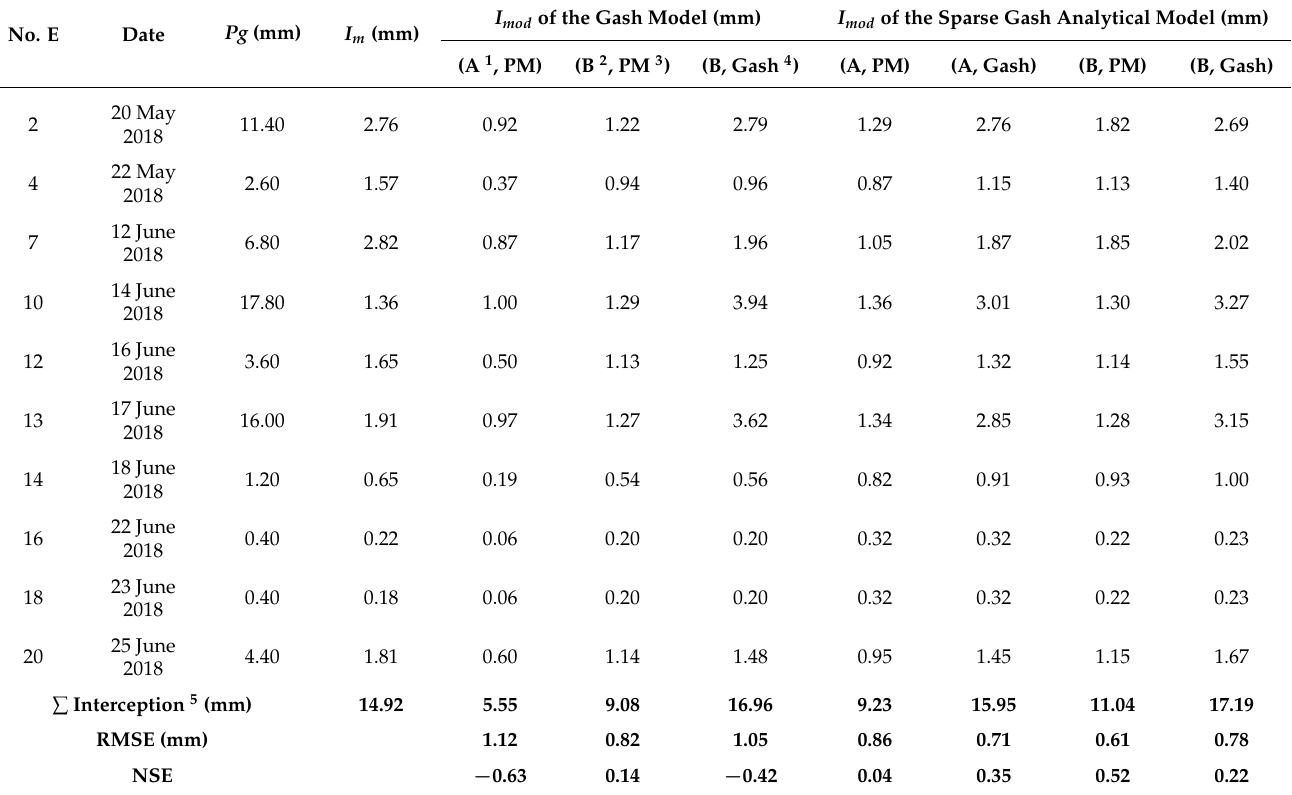
Table 10. Values of the interception observed ( I m ) and modeled ( I mod ) for A. religiosa with the combinations of the meteoro- logical and canopy